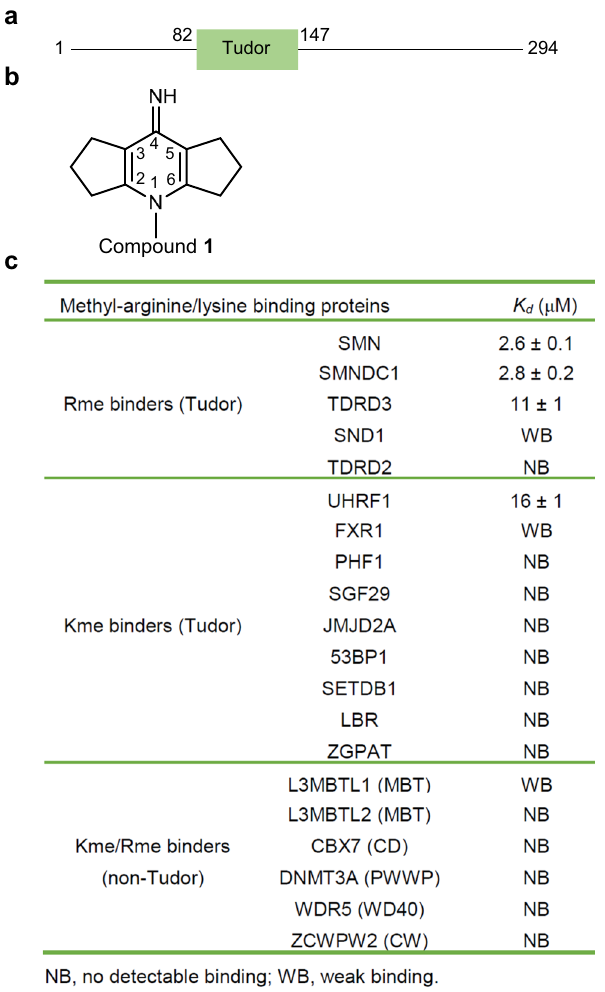
Fig.1|Compound 1 preferentiallybindstoSMNamongassayedmethylarginine or methyllysine binders. a Domain structure of SMN. b Molecular structure of compound 1 . c Binding af fi nities of compound 1 to selected modi fi ed histone readers measured by ITC. ITC data shown are representative of two independent experiments. The names of non-Tudor domains were shown in the parentheses. Source data are provided as a Source Data fi